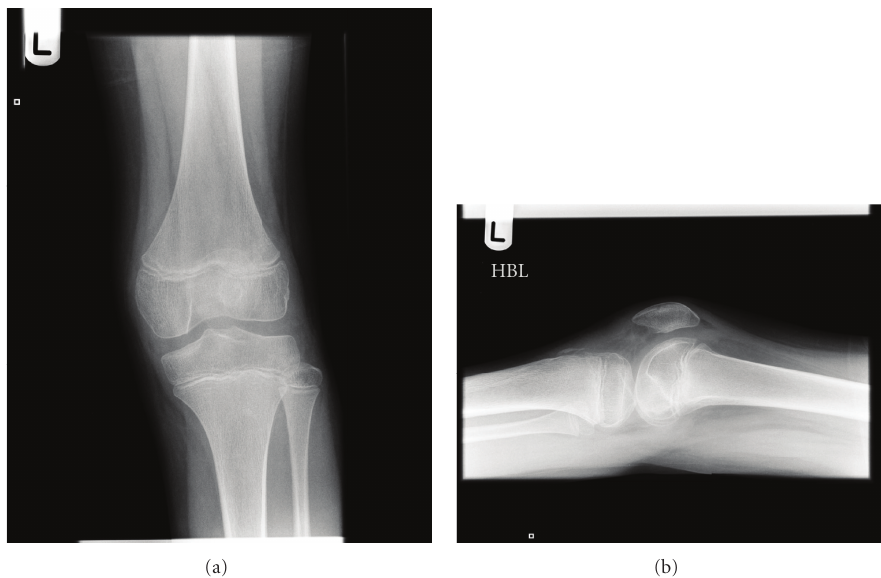
Figure 5: (a) Anteroposterior and (b) lateral views of the patients knee at three-month follow